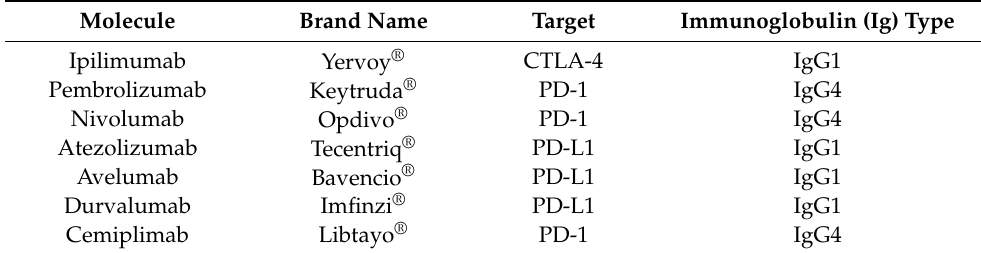
Table 1. US Food and Drug Administration (FDA) approved immune checkpoint inhibitors (ICIs) for cancer immunotherapy by chronological